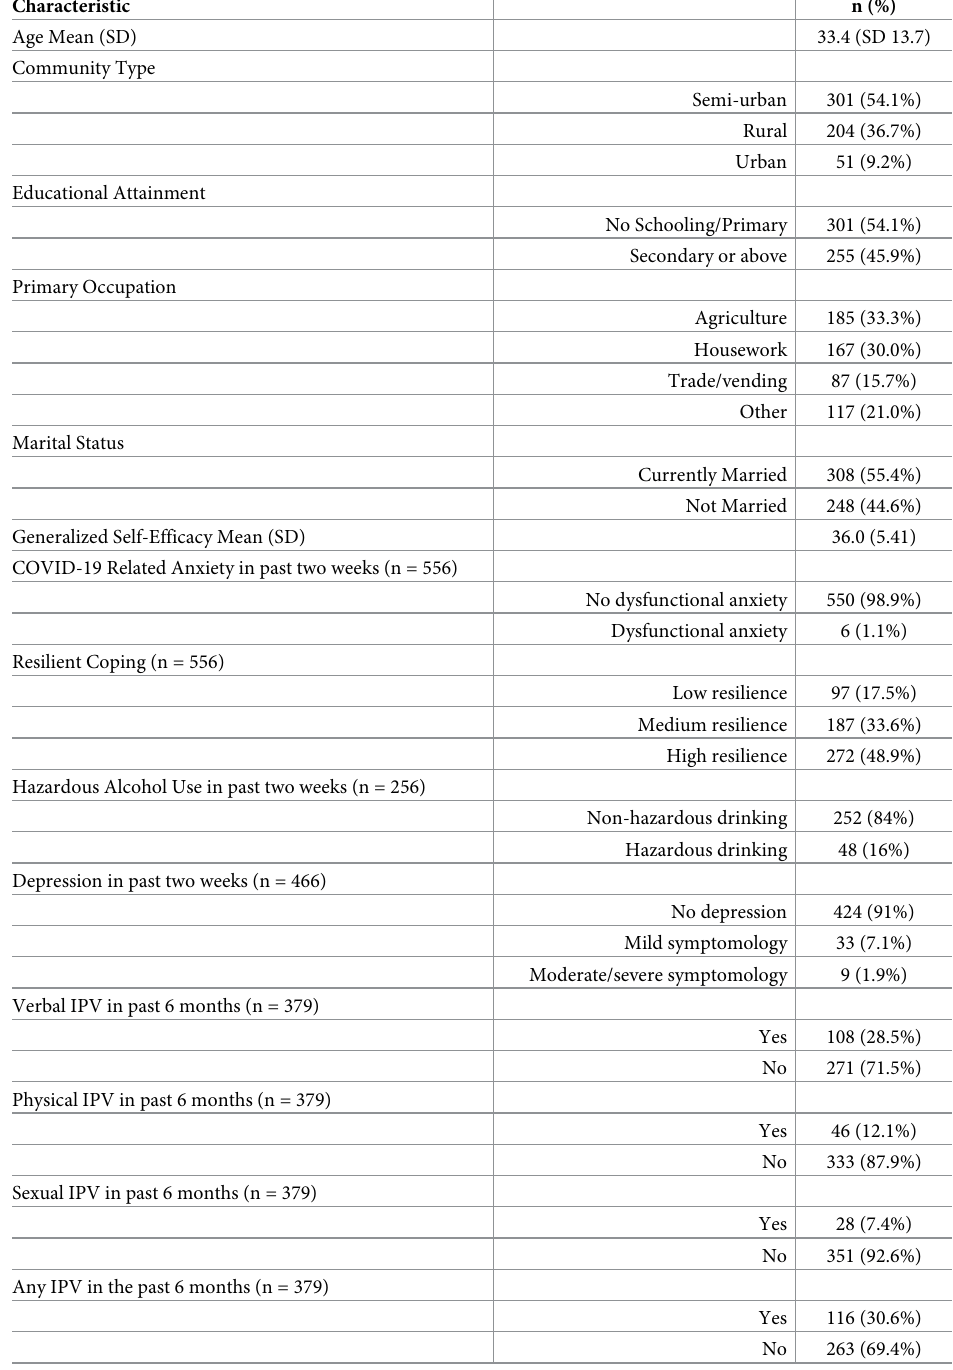
Table 1. Descriptive characteristics of the study sample (n =